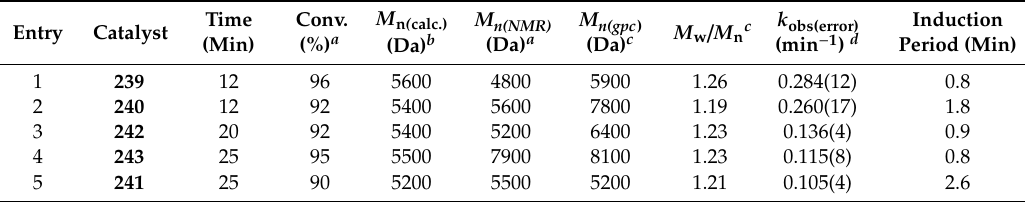
Table 9. ROP of ε -CL catalyzed by 239–243 [117].